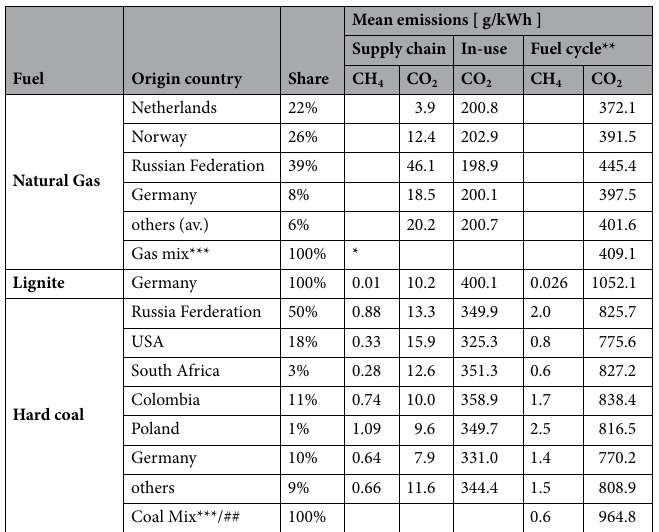
Table 2. Country specific mean CH 4 and CO 2 emissions for power generation in Germany used for fleet- conversion modelling reference year 2018; * see results section; **corrected for power plant fuel efficiency, *** normalized to country specific fuel share; ## Lignite and hard coal combined. See Supplementary Table S1 for full